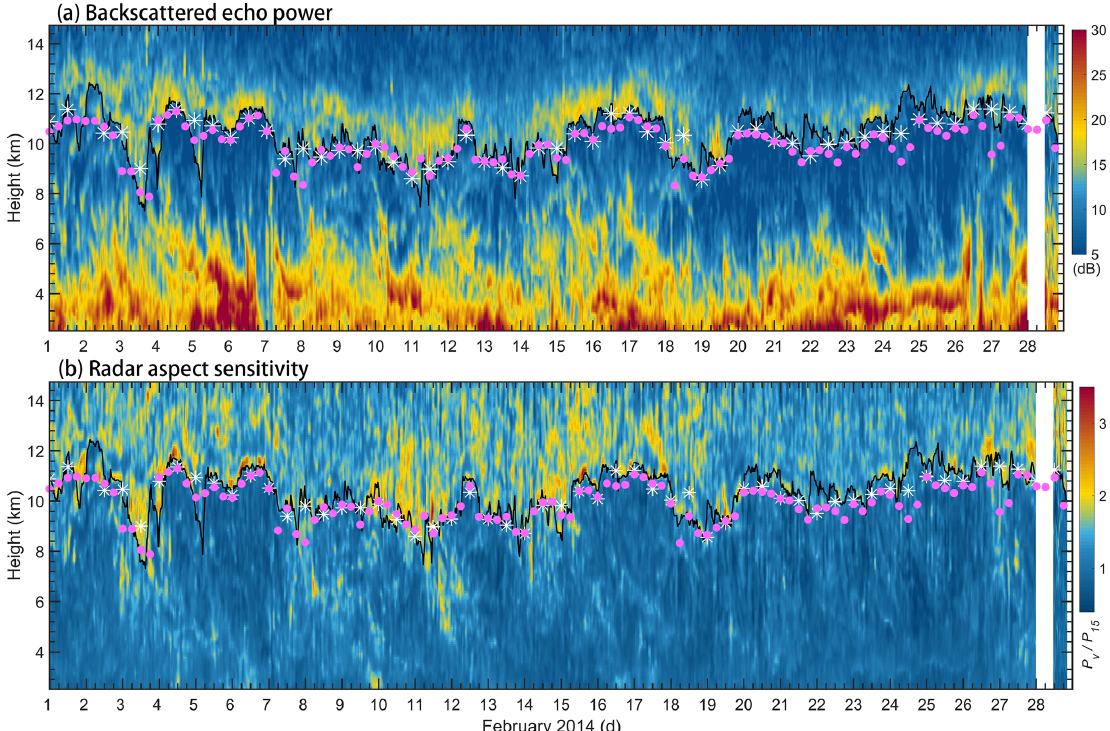
Figure 3. Altitude–time intensity plot of (a) radar backscattered echo power and (b) radar aspect sensitivity for February 2014. The tropopauses determined based on the radar echo definition are shown as a black solid curve. The white asterisks and pink dots indicate the location of the LRT derived from simultaneous twice-daily radiosonde data and the PVT from ECMWF ERA-Interim reanalysis, respec- tively. White stripe indicates the time frame of radar missing